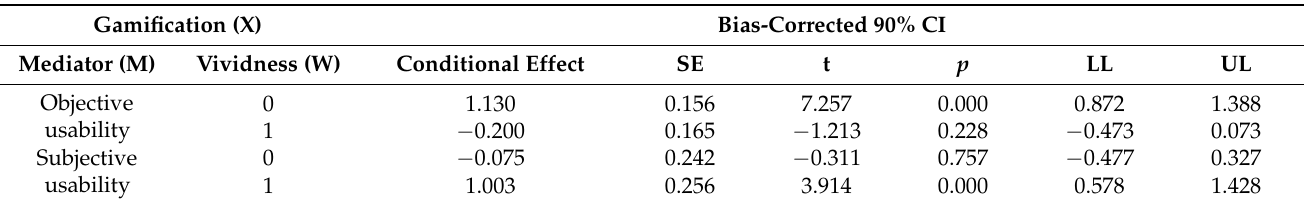
Table 12. Conditional effects of vividness on the objective and subjective usability of in-person counseling.